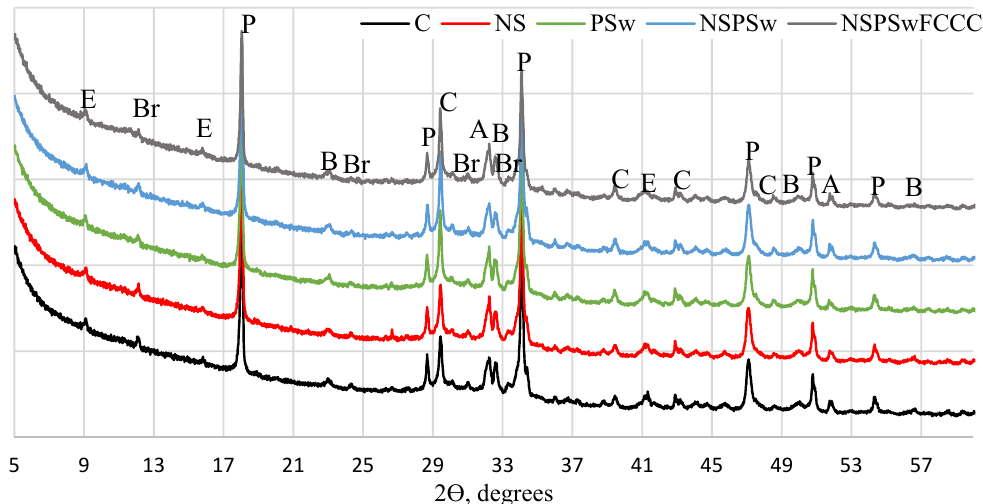
Figure 2. The comparison of the amount of minerals and amorphous phase at 7 days.